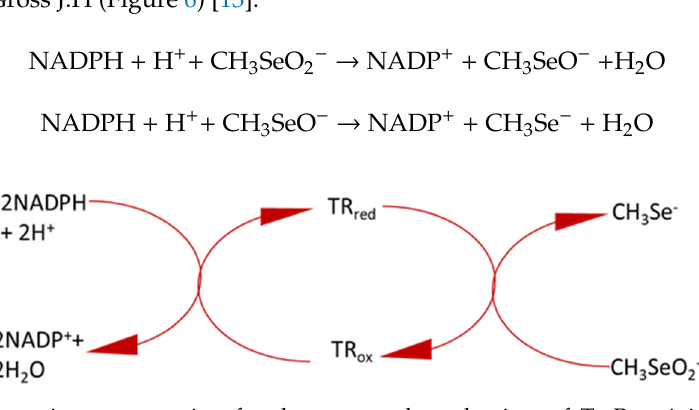
Figure 6. Schematic representation for the proposed mechanism of TrxR activity in reducing methylseleninate [13] .